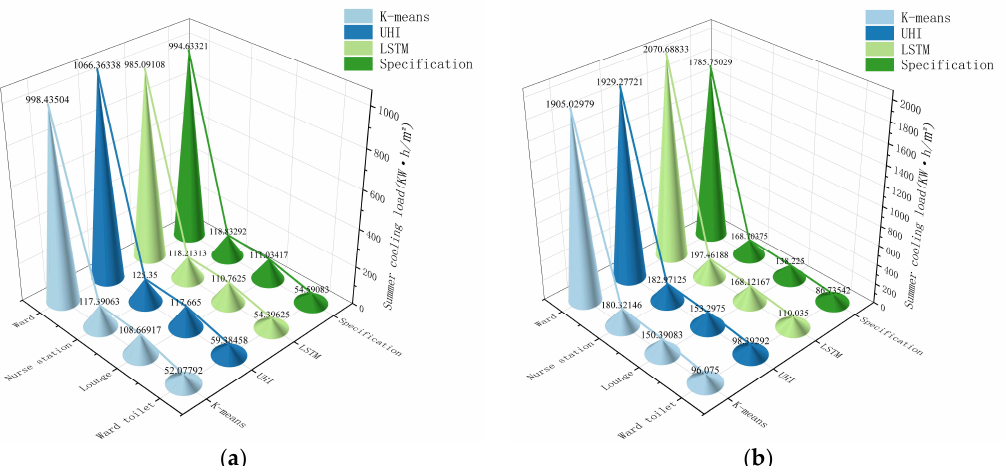
Figure 19. Statistics of summer cooling load in Beijing ( a ) and Shanghai ( b ) inpatient buildings.